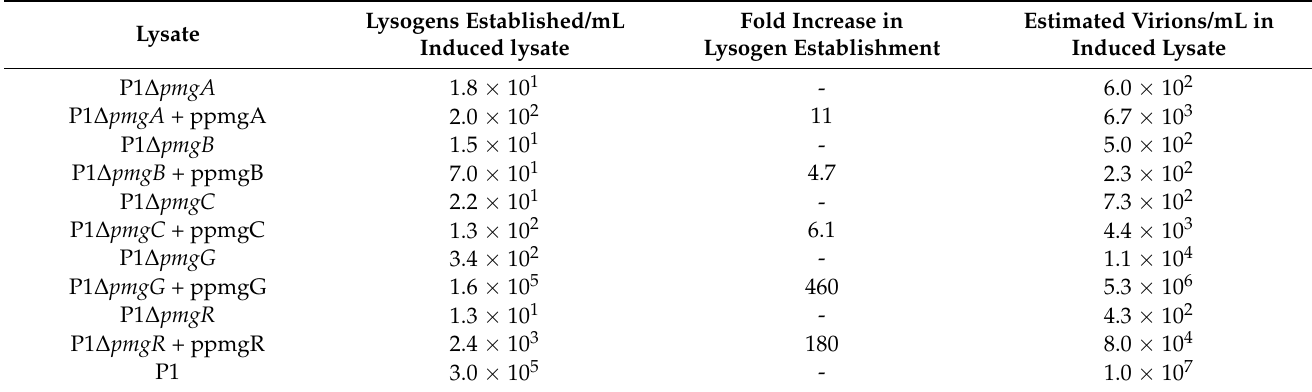
Table 2. Complementation of putative morphogenetic gene knockouts. Complementation of all mutants except for pmgR did not rescue the plaque-forming phenotype, thus complementation was observed by the restoration of the ability to produce infections virions that can establish lysogens in new